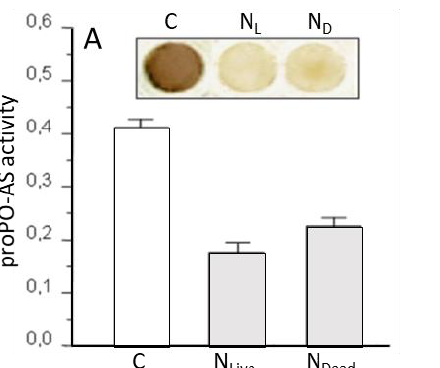
Figure 13. ( Left ) Effects of the presence of live and dead S. feltiae inside host hemocoel 30 min after infection, the presence of parasites induces a marked inhibition of phenoloxidase activity; the upper box shows the lack of melanin due to the presence of live or dead nematodes (N L , N D ). ( Right ) Co-incubation of live parasites with G. mellonella cultured hemocytes, showing the absence of cellular encapsulation. Bar = 100 µ m, (from [146]).